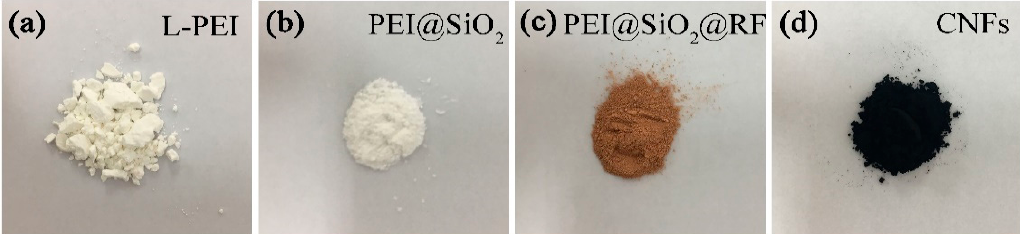
Figure 2. Photographs showing the evolution from linear PEI precursor to the CNFs during the synthesizing process. ( a ) Linear PEI, ( b ) PEI@SiO 2 , ( c ) PEI@SiO 2 @RF and ( d ) CNFs.